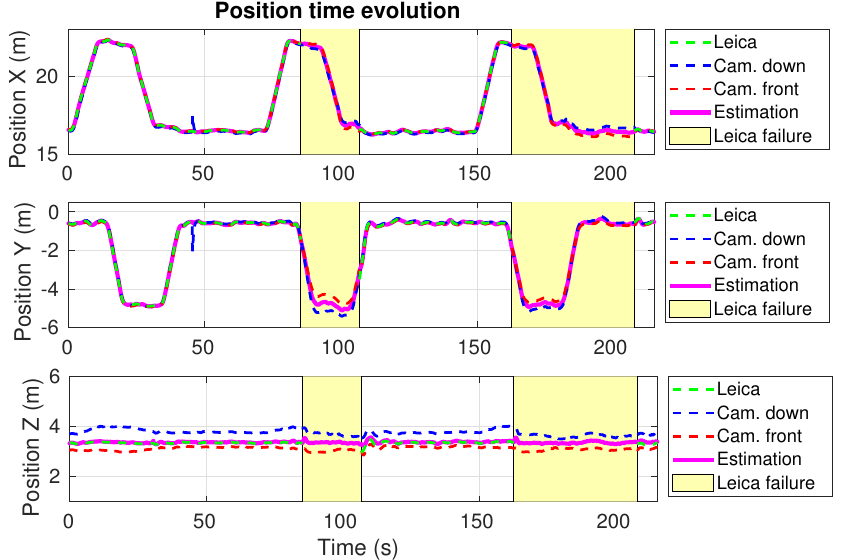
Figure 7. Experiment 1. Time evolution of the estimated X, Y and Z UAV positions provided by our localization system (magenta), the two calibrated camera measurements (blue and red), and the Leica total station (green). The intervals without total station data are shown in